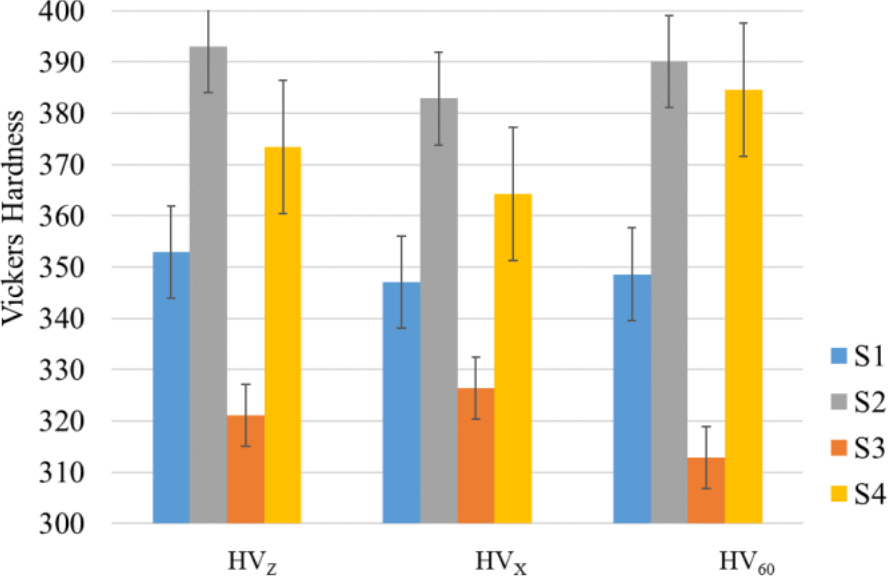
Figure 7. Vickers microhardness results for the four groups of the samples in selected planes. The oxygen content is a crucial parameter in EBM that affects the mechanical perfor- mance of Ti-6Al-4V parts. Table 4 shows that powder recycling causes oxygen growth both in powder and in samples built from the reused powder [18]. Table 4. Oxygen content in powder, in as-built and treated samples (the data acquired from [18]).